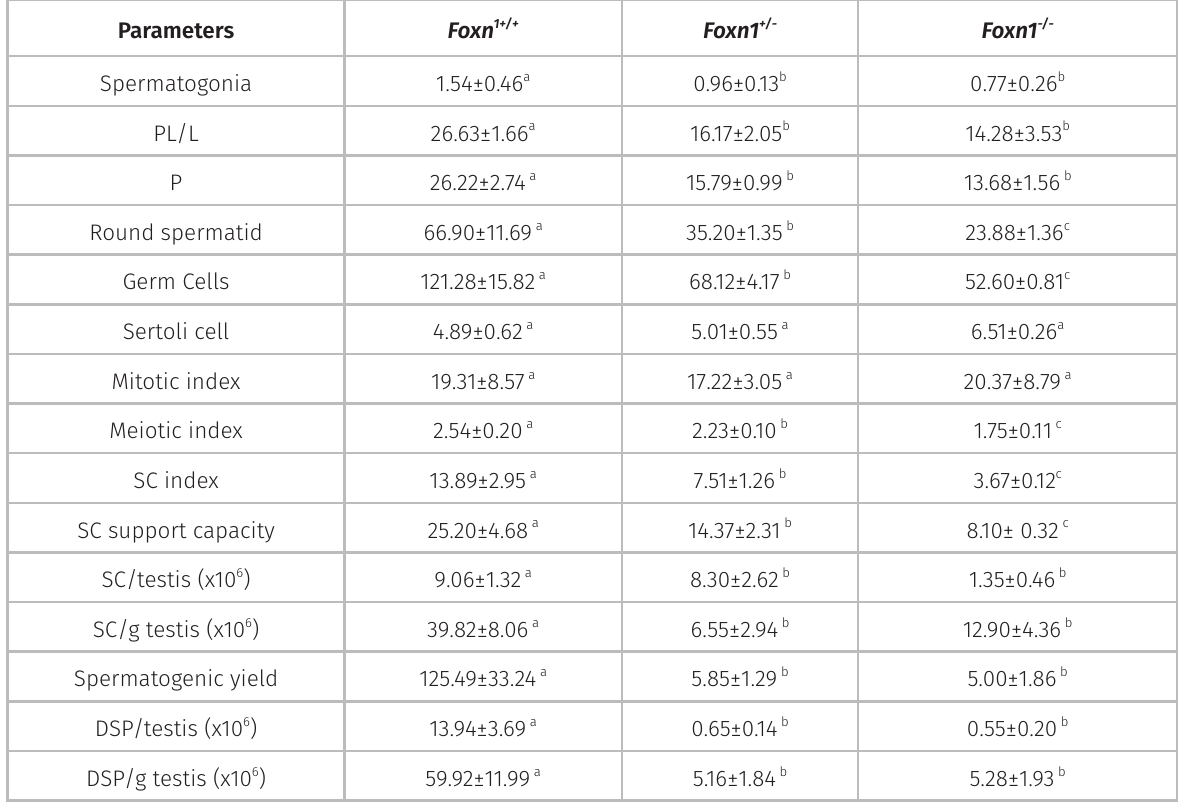
Table III. Germ and Sertoli cells count in seminiferous tubules cross-sections (Stage I of the seminiferous epithelium